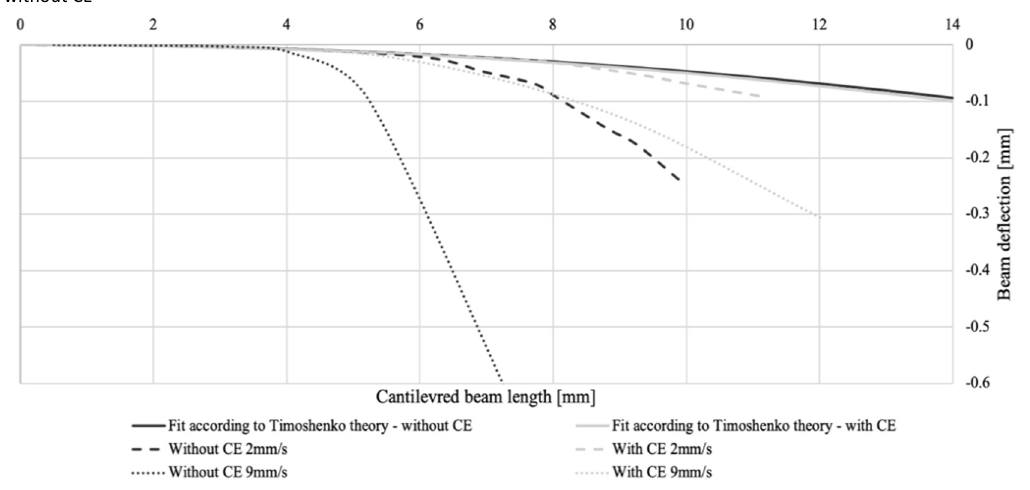
Figure 3. Tip deflection versus extruded specimen length. Comparison between experimental results and the Timoshenko beam theory for a material with